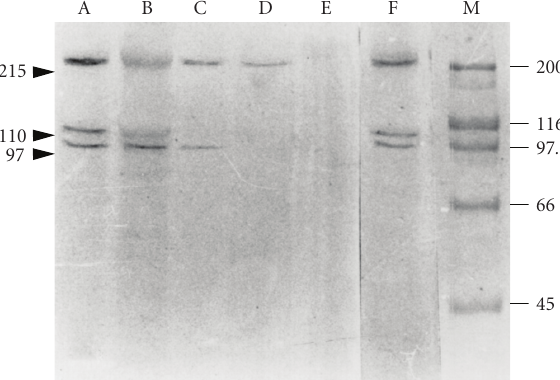
Figure 5: In vitro proteolytic degradation of collagen type V by purified metalloprotease from Cryptobia salmositica. Lanes A–E: collagen incubated with metalloprotease for 0, 2, 4, 6, and 8 hours respectively; lane F: collagen incubated under same conditions as lanes A–E, but without metalloprotease (control); lane M: molecular markers (reproduced from Zuo and Woo [18]).